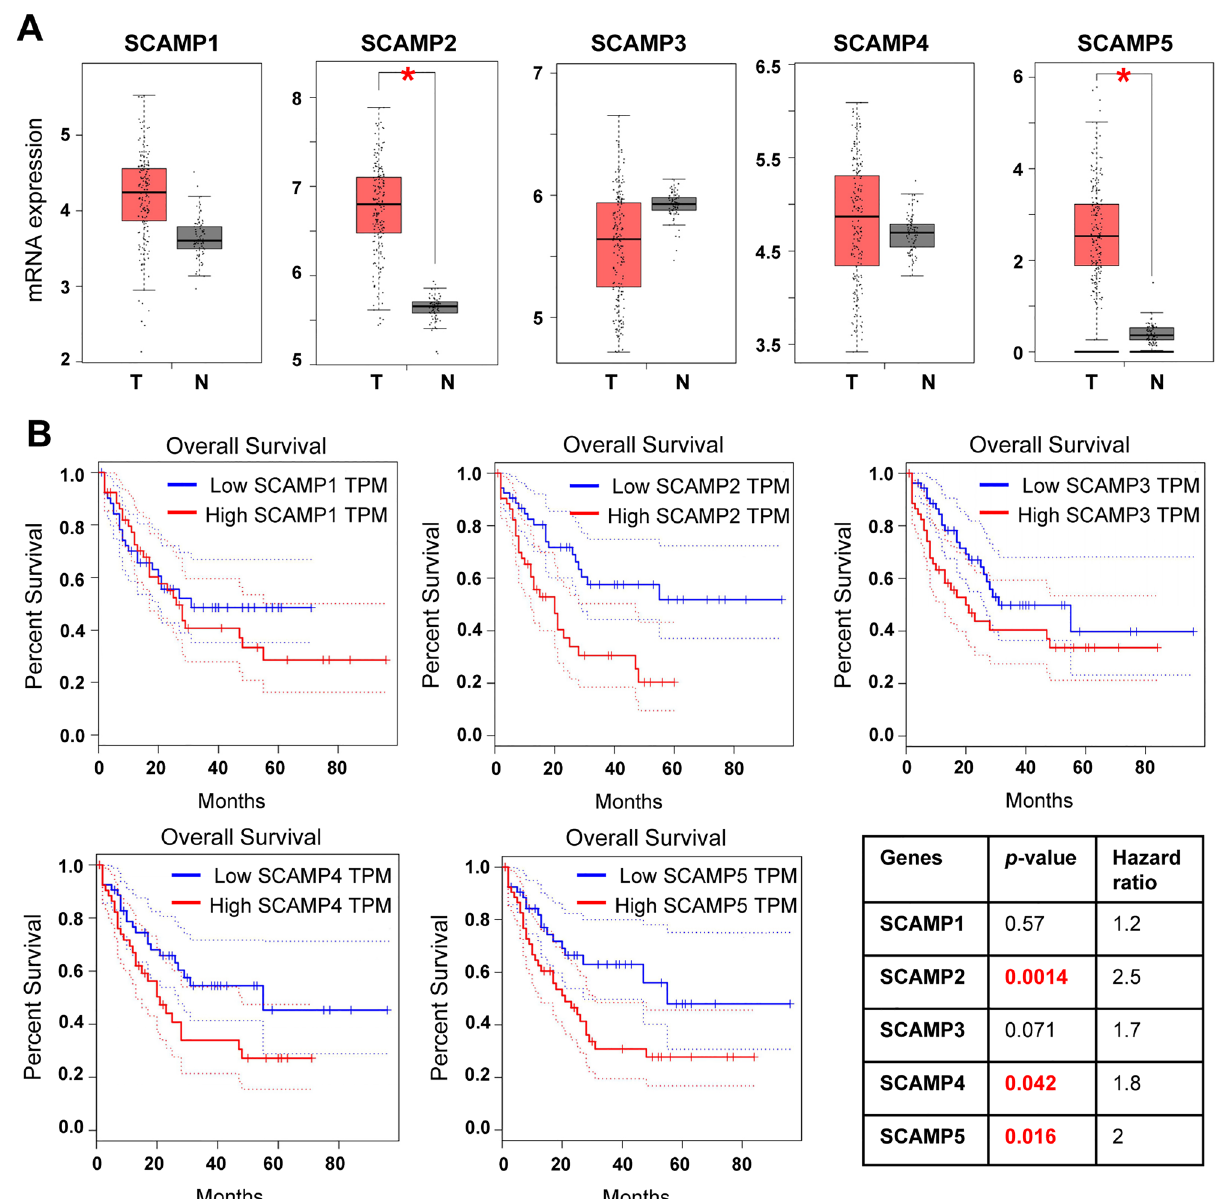
Figure 3. SCAMP mRNA levels and the prognostic value of the individual SCAMP in AML (GEPIA database). (A) The distribution of SCAMP1-5 gene mRNA expression between AML and normal controls. n (tumor, T) = 173; n (normal control, N) = 70. (B) Curves show relative expression of SCAMP1-5 with overall survival between AML and normal controls using GEPIA. For SCAMP1, n (high) = 52, n (low) = 52. For SCAMP2-5, n (high) = 53, n (low) = 53. P value of log-rank and hazard ratio were